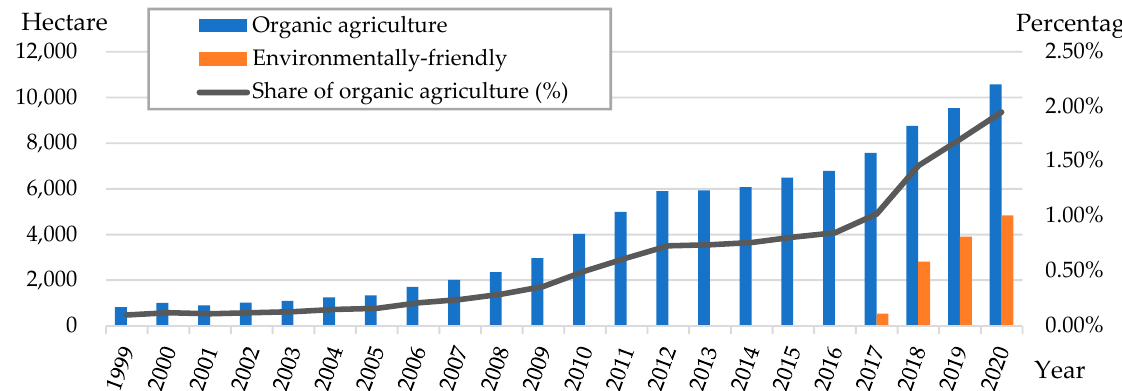
Figure 1. Land area and share of organic agriculture in Taiwan. Source: Adapted from [16], with permission from Organic Agriculture Promotion Center (OAPC), 2021. OAPC official website: www.oapc.org.tw.